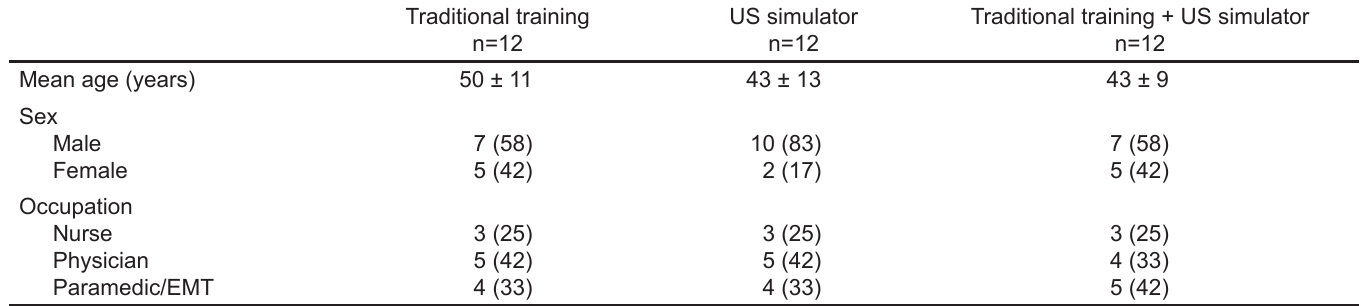
Table. Baseline characteristics of participants in FAST training.